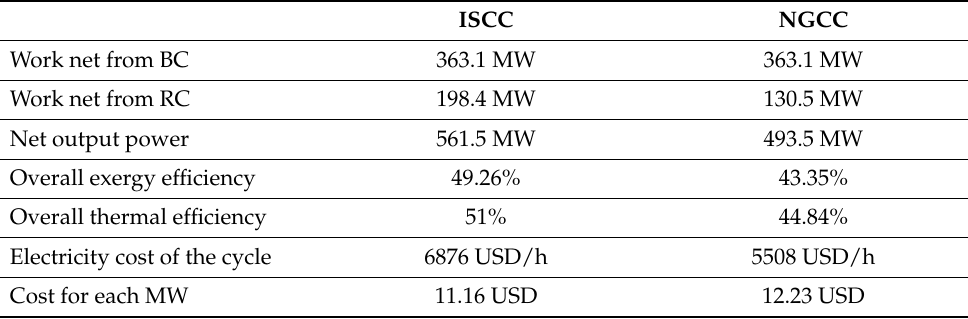
Table 8. Performance and cost of the NGCC and ISCC cycles.